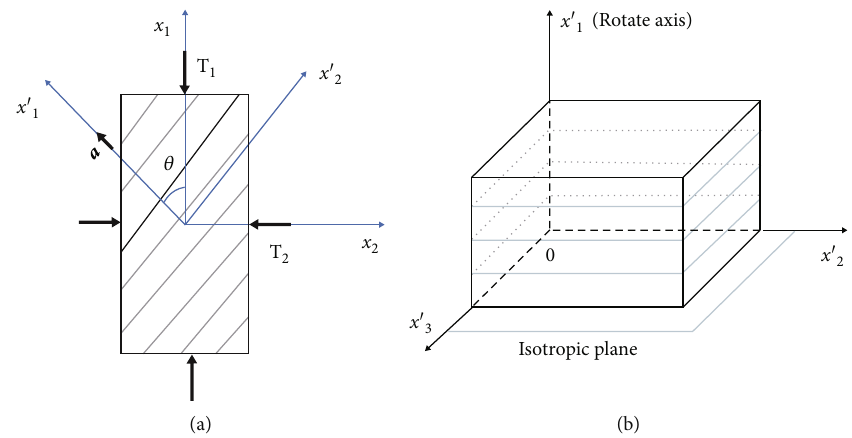
Figure 1: Coordinate system (a) and isotropic plane (b) of transverse isotropic sand.